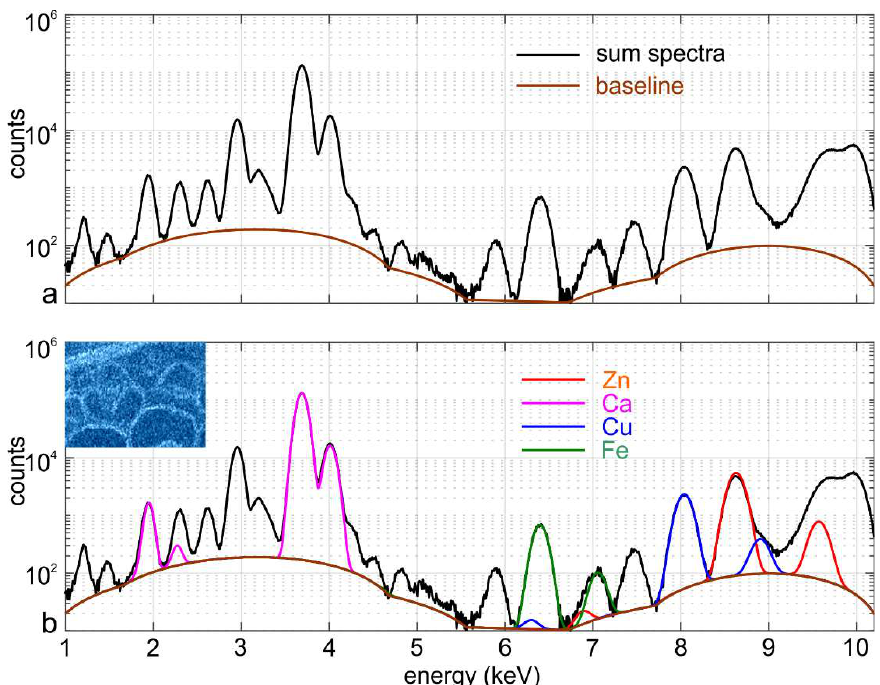
Figure A4. ( a ) Total XRF spectrum from Figure 4c. ( b ) Elemental peaks deconvolution showing the presence of Cu and Zn in the growing edge of Pinctada .